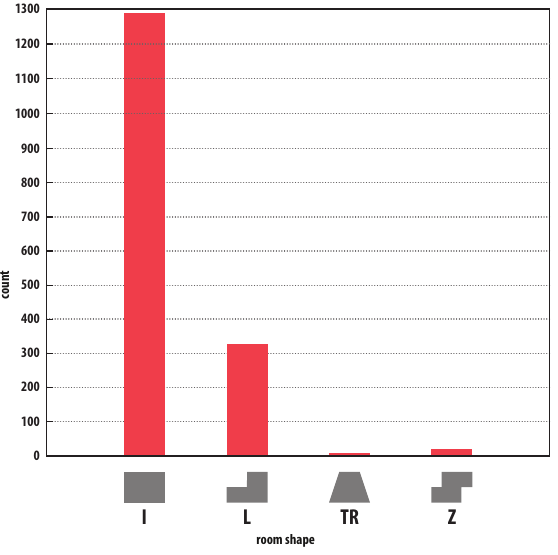
Figure 8. Underlying room shapes in our spatial database. I-, L-, TR- (Trapezoidal) and Z-shaped rooms have been